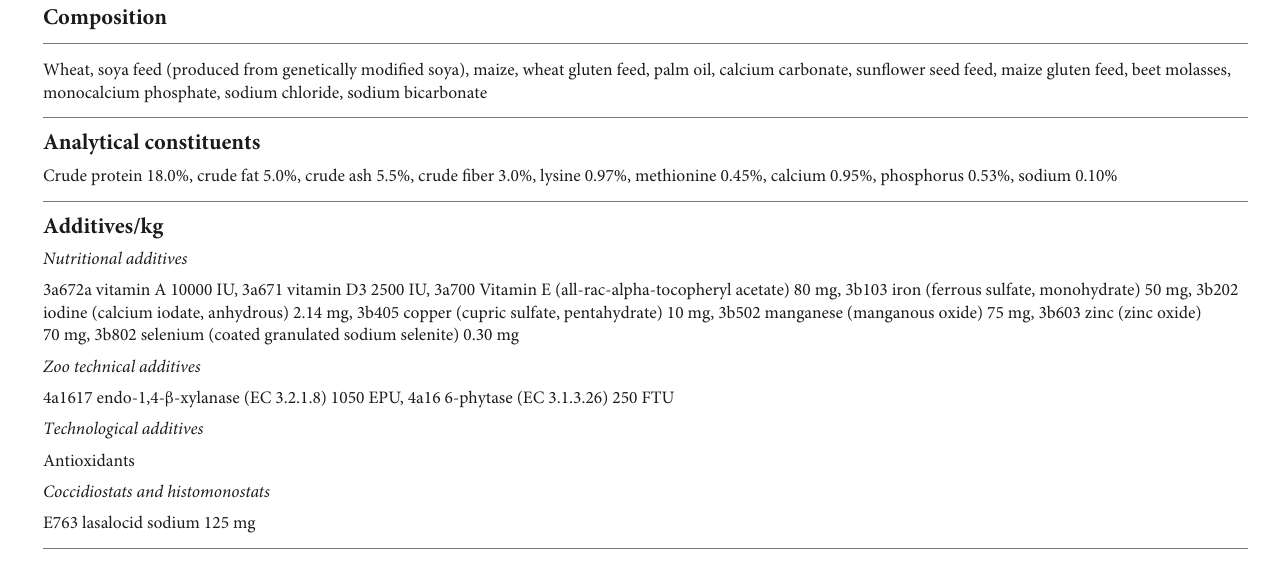
TABLE 1 Composition of the broiler diet (Farm mash 1&2, Versele-Laga).